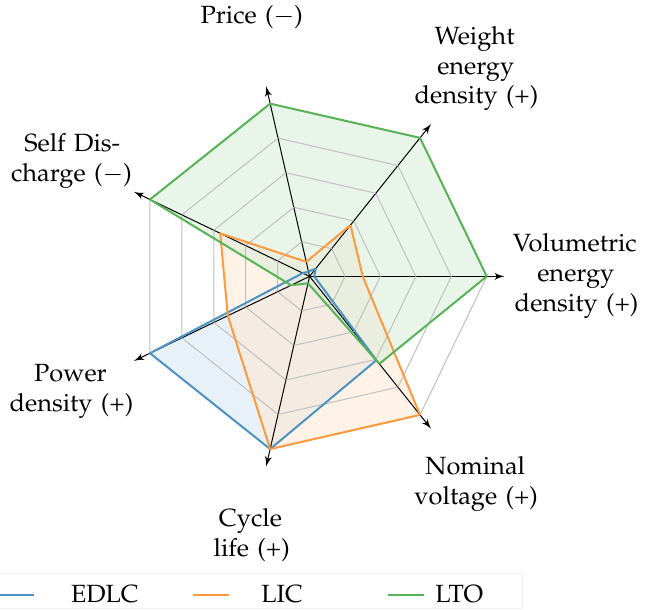
Figure 9. Spin chart comparing properties of energy storage compounds EDLC (orange) LIC (blue), and LTO (green). (+) higher is better, ( − ) lower is better.